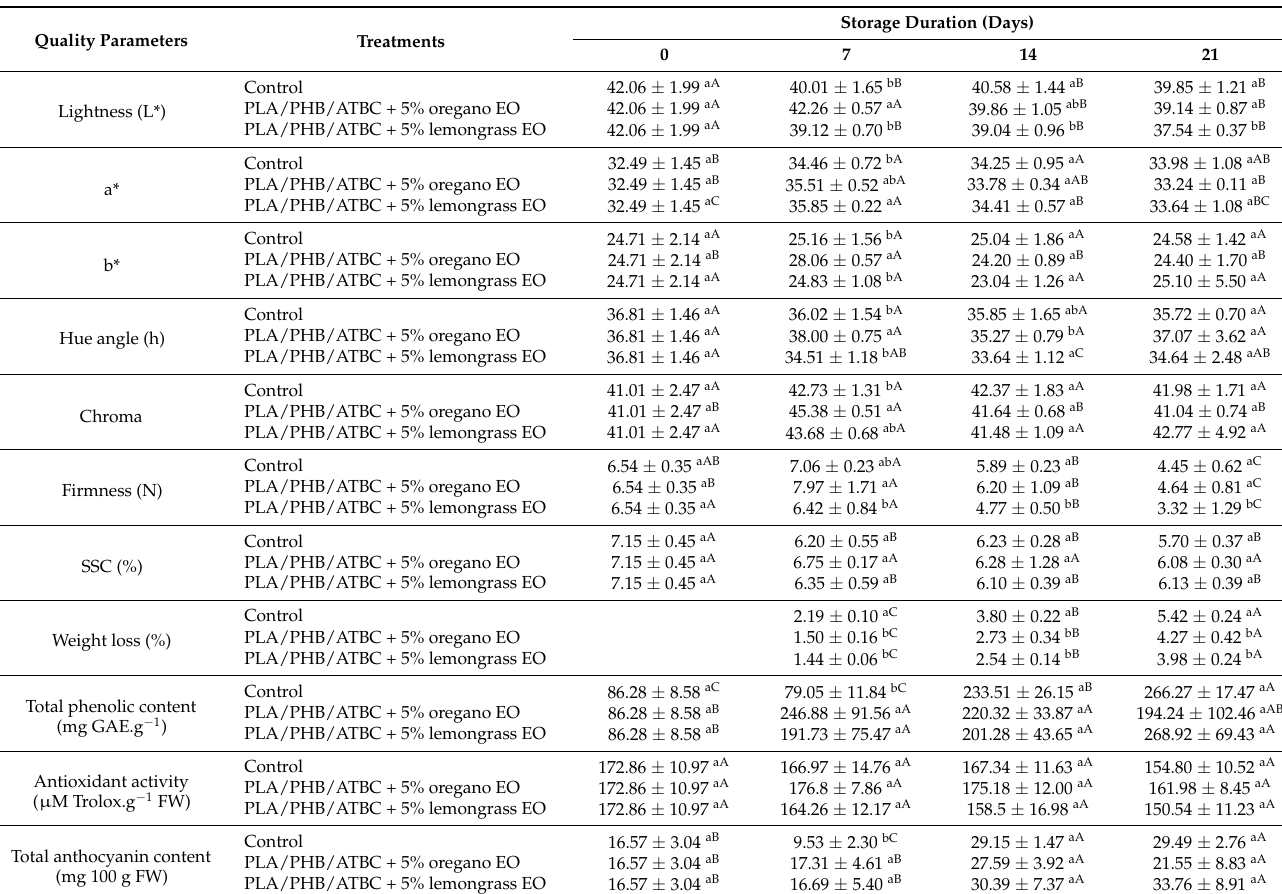
Table 1. Changes in quality parameters of strawberry for 3 weeks of storage for control and treatment by PLA/PHB/ATBC + 5% oregano EO and PLA/PHB/ATBC + 5% lemongrass